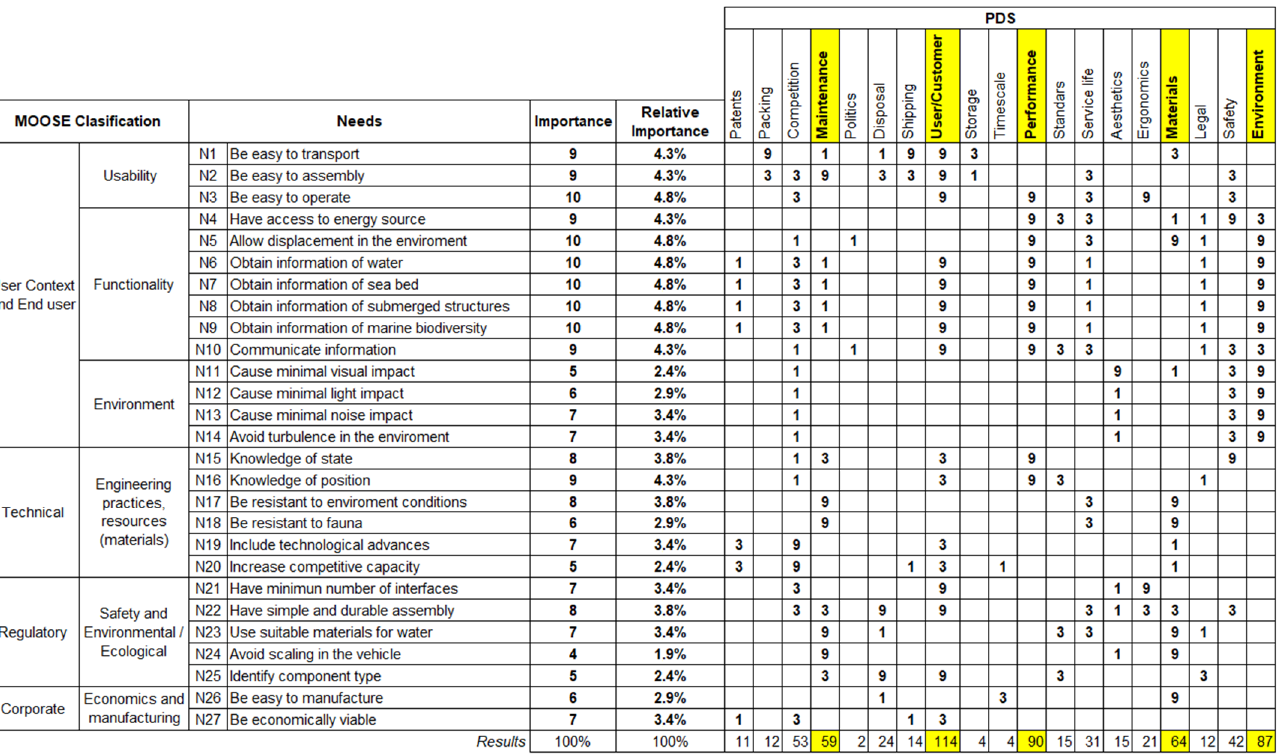
Figure 9. Matrix of relationships between needs and ROV PDS. Table 1. Example of an extract of questions to elicit needs in relation to the PDS of the next stage. Questions for Needs